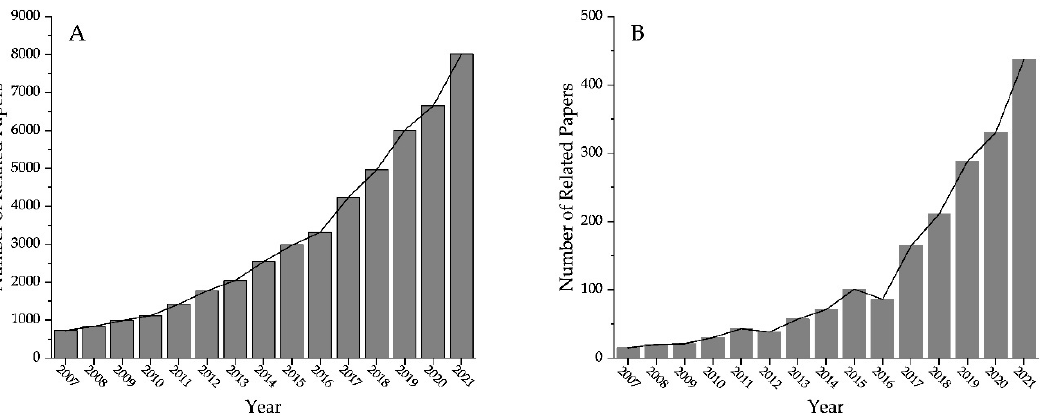
Figure 1. Statistical analysis of the number of related papers published in Web of Science with the